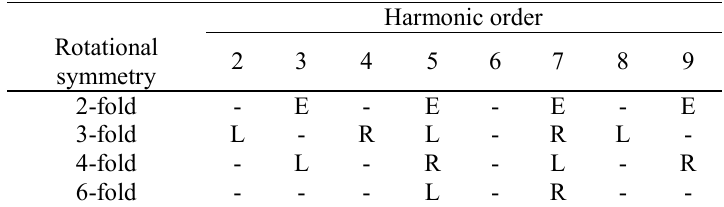
Table 1. Selection rules for circularly polarized HHG driven by right-circularly polarized pulses. Harmonic order Rotational